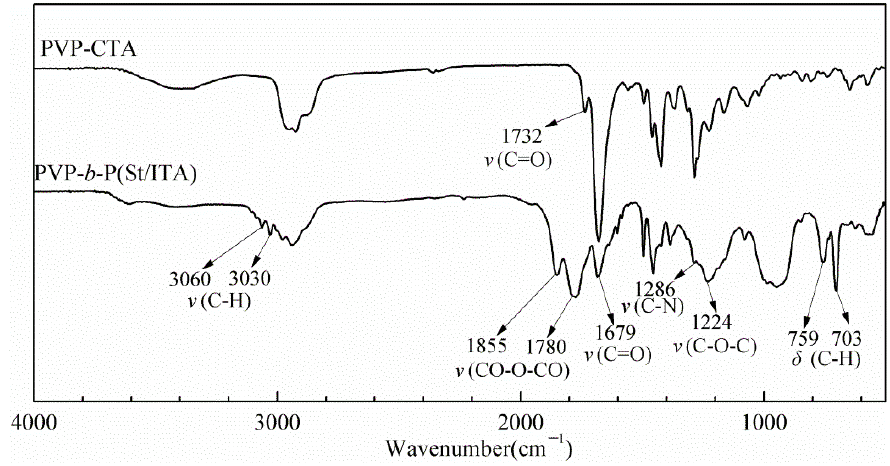
Figure 4. Infra-red spectrogram of PVP-CTA and PVP- b -P (St/ITA).